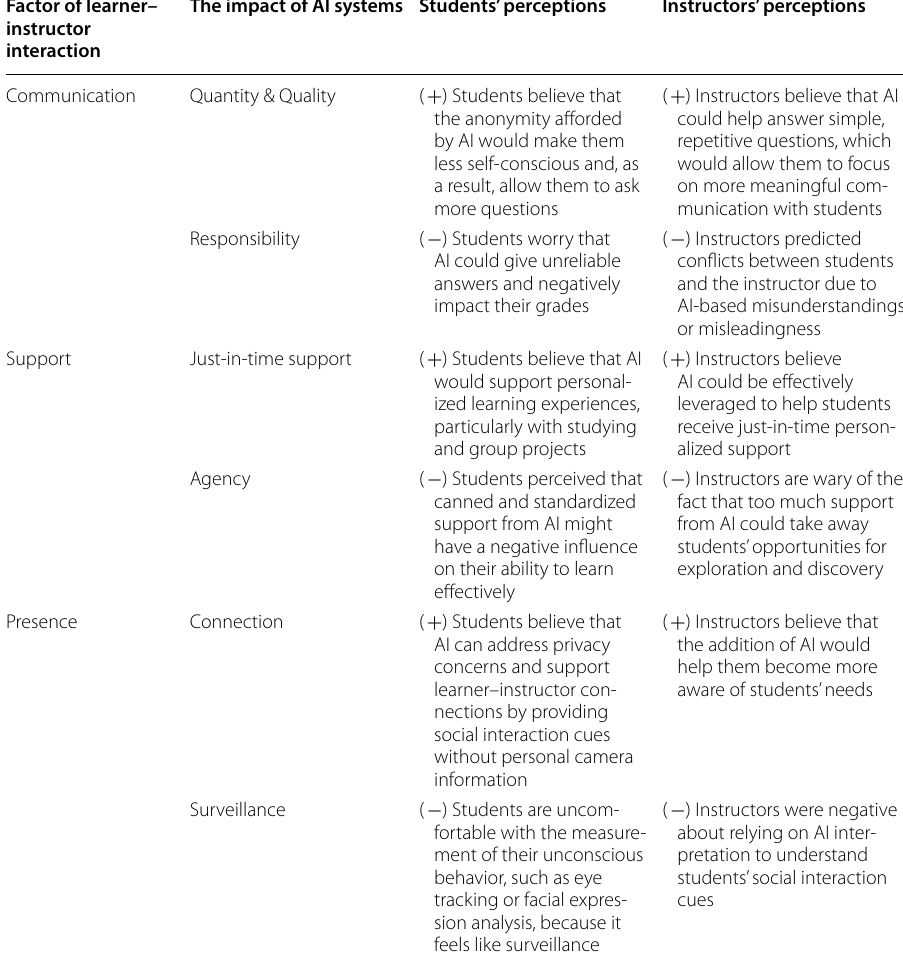
( ) indicates perceived benefit and ( +